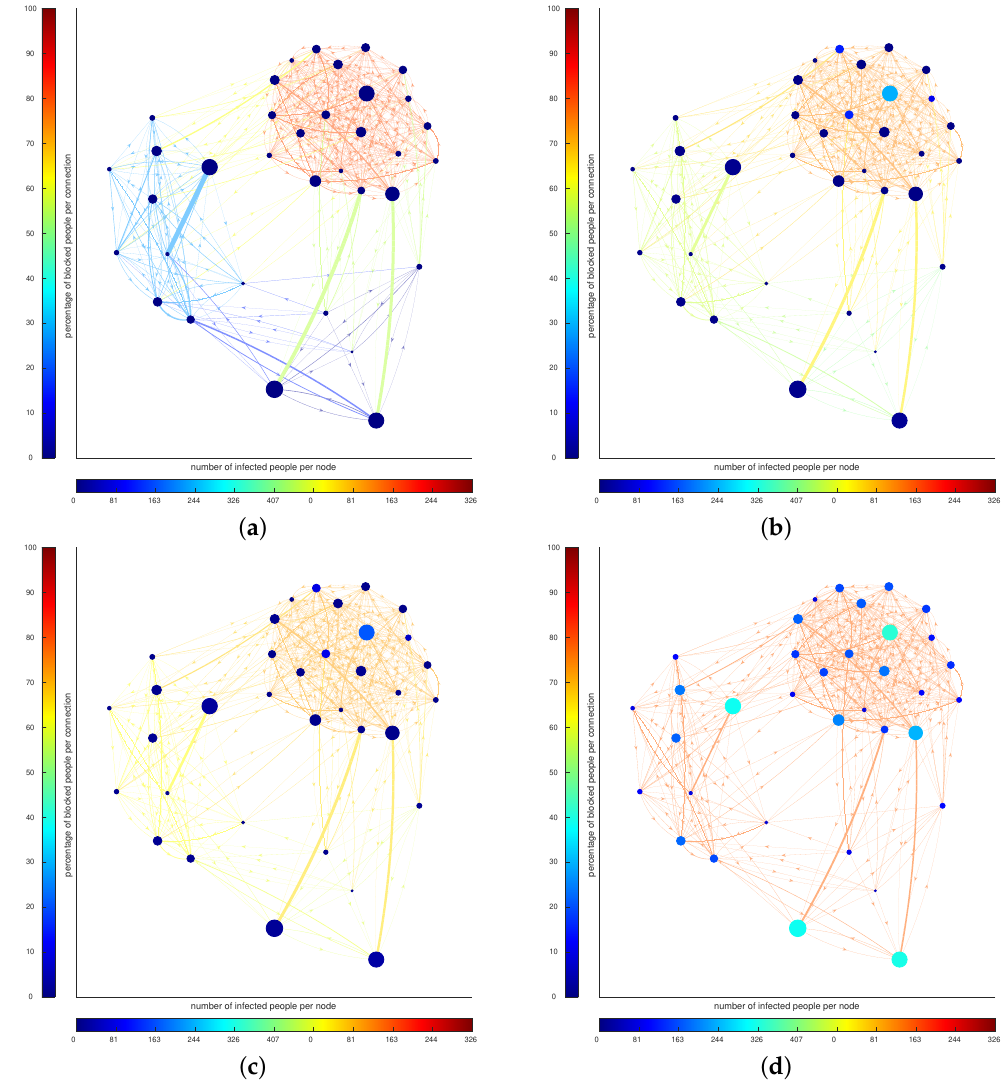
Figure 2. ( a – d ): Evolution of the strategy and infected people in Scenario B for timestamps t = 0,20,40,179, respectively. The color of the nodes represents the number of infected people in that node, while the color of the edges represents the percentage of people